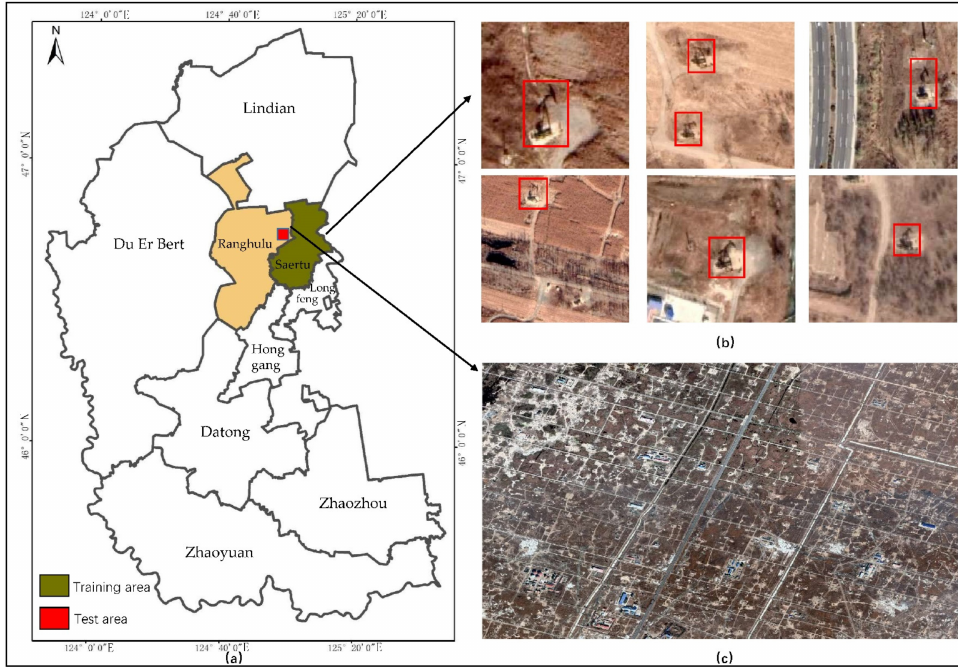
Figure 5. Study area: ( a ) location of Daqing City; ( b ) clear image blocks of the oil well in the training area; ( c ) part of remote sensing image of the test